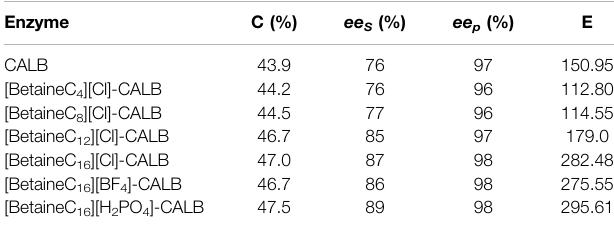
TABLE 2 | Native and modi fi ed lipase-catalyzed hydrolysis of (R,S)-1-Phenethyl acetate.